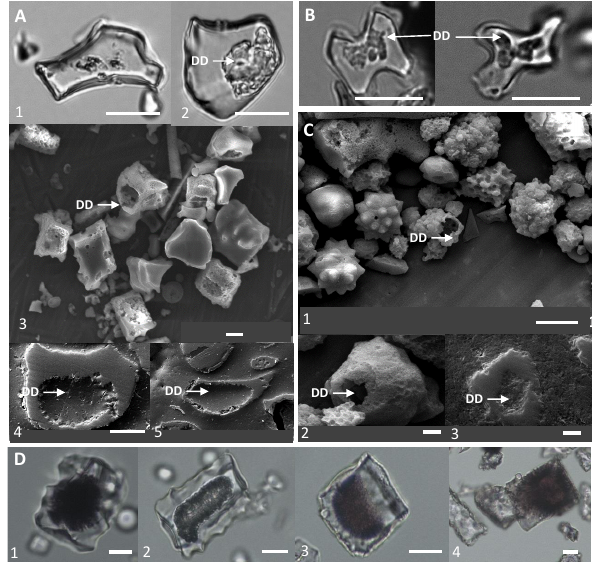
Figure 9. Figure 9. NL microscopy and SEM images of dissolution depres- sions (DD) affecting fossil phytoliths from soils. (a) Grass epider- mis monocellular phytoliths (cuneiform bulliform types and aci- cular type) from Mascareignite (MSG 70, La Réunion, France) (Crespin et al., 2008); NL microscopy phytolith surface (1, 2), SEM phytolith volume (3) and polished section (4, 5). (b) Grass epi- dermis monocellular phytoliths from a ferrugineous soil (Salitre, Brazil) (Alexandre et al., 1999); NL microscopy phytolith. (c) Phy- toliths from palms and trees from a ferallitic soil (Dimonika, RDA) (Alexandre et al., 1997); SEM globular granulate type volumes (1, 2) and polished section (3). (d) Opaque areas observed with NL microscopy on bulliform cell phytoliths from MSG 70 (1, 2) and Salitre (3, 4). Scale bars: